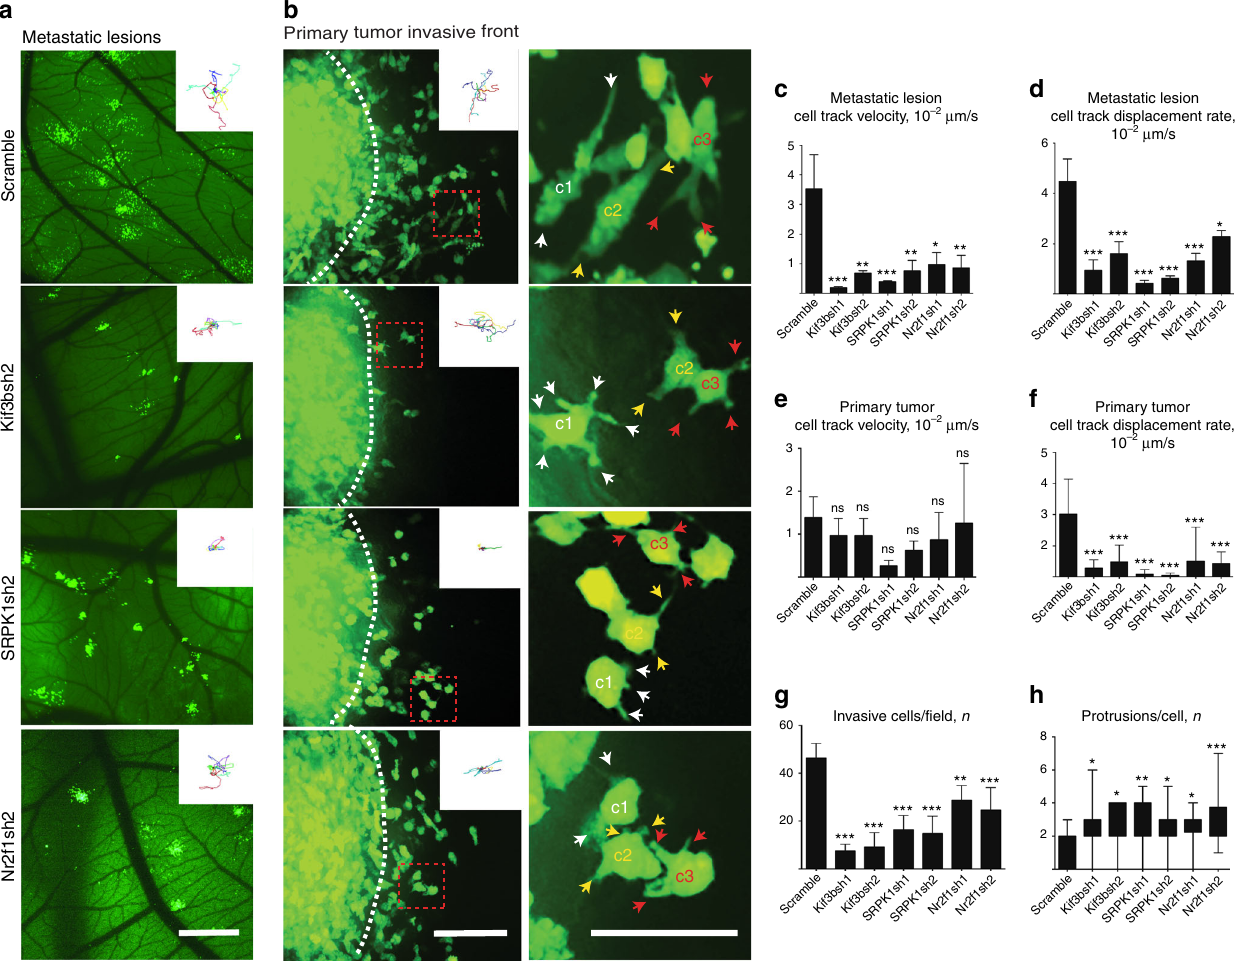
Fig. 2 Screen-identi fi ed genes are required for productive cancer cell invasion in vivo. An intravital imaging approach was utilized to visualize and quantify the behavior of cancer cells in metastatic colonies and primary tumors over 7 or more hours. a Metastatic colonies arising from single HEp3 cells transduced by scramble shRNA or shRNAs targeting KIF3B, SRPK1, or NR2F1. Insets show representative cell tracks within the metastatic colonies. b Visualizing the invasive front of primary tumors (left panel) produced by HEp3 cells transduced by scramble shRNA or shRNAs targeting KIF3B, SRPK1, or NR2F1. Insets show representative cell tracks at the invasive fronts. Right panel shows a close-up of the cells from red dashed squares in the left panel. Color-coded arrows point to cell protrusions formed by the individual, correspondingly color-coded labeled cells (c1 − c3). c Average in vivo cancer cell migration velocity for control and knockdown clones in metastatic colonies. d Average in vivo cell displacement rate (productive migration) for control and knockdown clones in metastatic colonies. e Average in vivo cancer cell migration velocity for control and knockdown clones in the invasive front of primary tumors. f Average in vivo cell displacement rate (productive migration) for control and knockdown clones in the invasive front of primary tumors. g Average number of invasive cells per fi eld that migrated beyond the primary tumor periphery. h Average number of protrusions per cell for control and knockdown clones. Scale bars = 500 μ m ( a ); 200 μ m ( b , left panel) or 20 μ m ( b , right